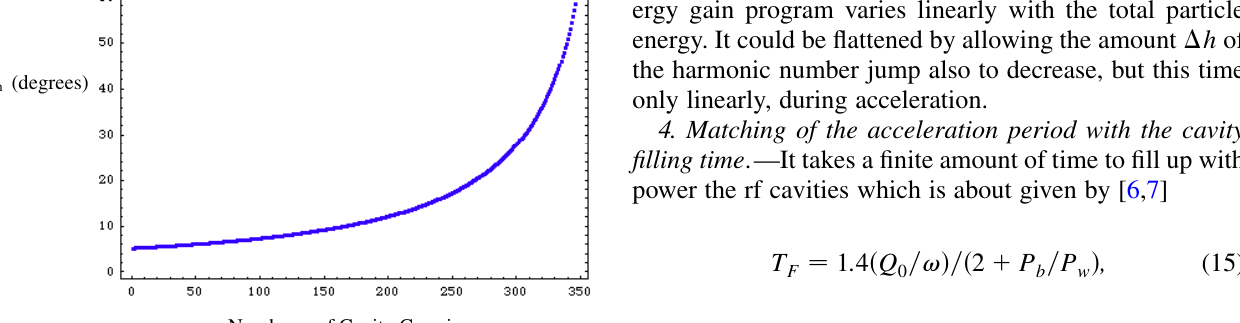
program versus number n of cavity n